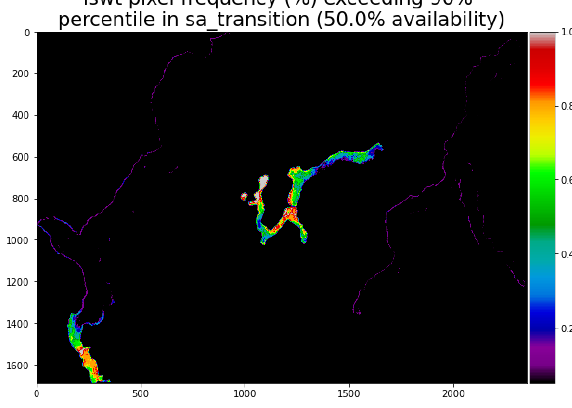
Figure 22. LSWT - spatial pattern map in summer - autumn